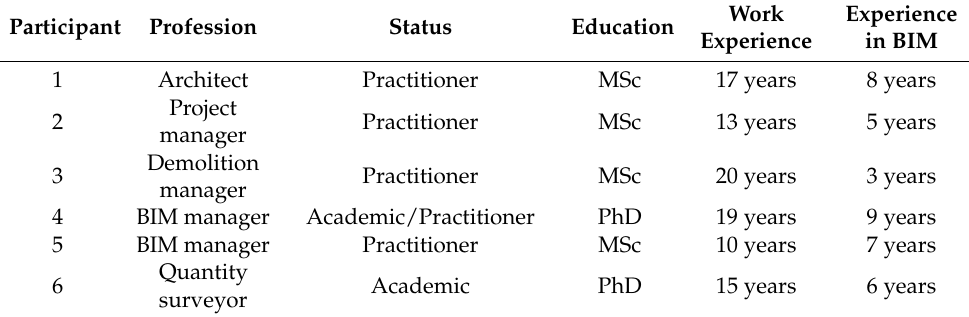
Table 3. Participant’s